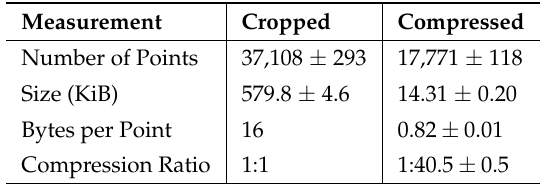
Table 3. Octree Compression Results, 4cm octree resolution. The results are mean values over 1000 measured point clouds, with the number of points rounded to the nearest integer.